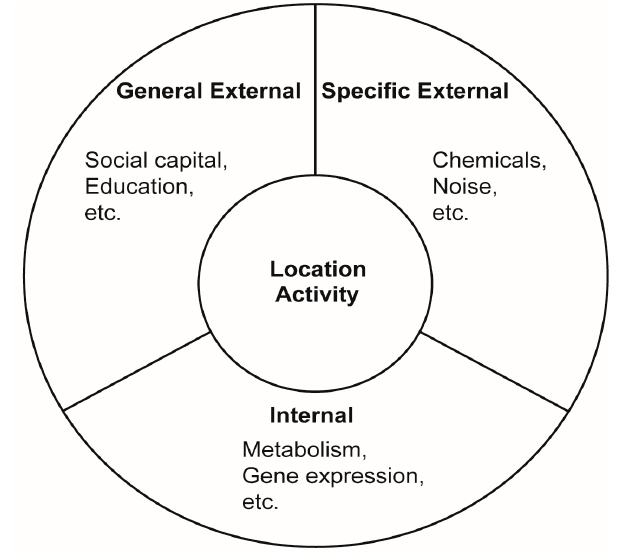
Figure 1. Adaptation of the three spheres of the exposome, as defined by Wild [4], showing that assessing a person’s location and activity patterns influences all areas of the exposome.